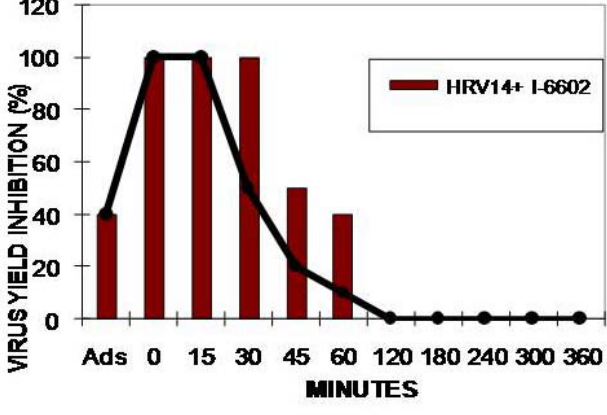
Figure 2. Time-addiction effect of compounds I-6602 (0.5 µg/mL) and pirodavir (0.5 µg/mL) on HRV14 at various times of incubation during the viral replicative